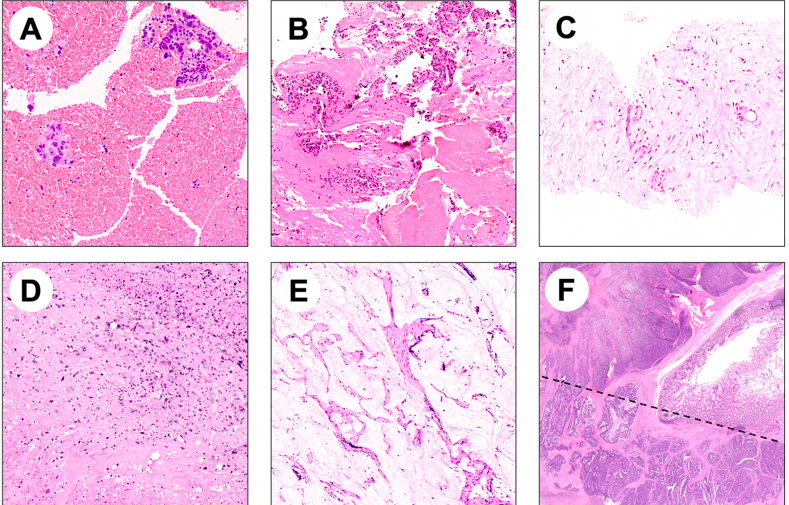
Figure 1. Representative images of potential pitfalls in NGS analysis of FFPE bioptic and surgical specimens. ( A , B ) Hematic material enclosing few adenocarcinoma glands; ( C ) biopsy specimen composed of fibrotic tissue enclosing rare adenocarcinoma glands; ( D ) scattered tumor cells surrounded by necrosis and fibrosis in a metastatic surgical resection specimen; ( E ) mucinous adenocarcinoma characterized by low cellularity and mucinous acellular component; ( F ) intratumor heterogeneity may hamper NGS analysis if both components are not considered (a morphologically heterogeneous colorectal adenocarcinoma composed by glandular and solid areas is shown).